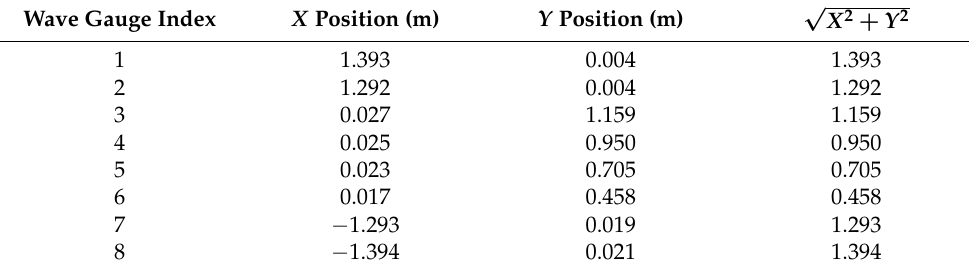
Table 2. Wave gauge positions relative to the buoy